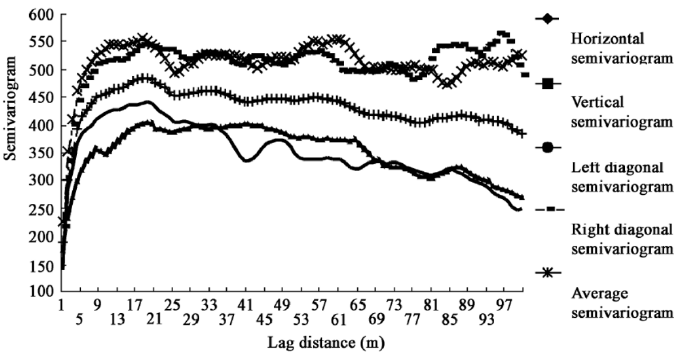
Fig. 8 The semivariance of the urban landscape sub-areas test